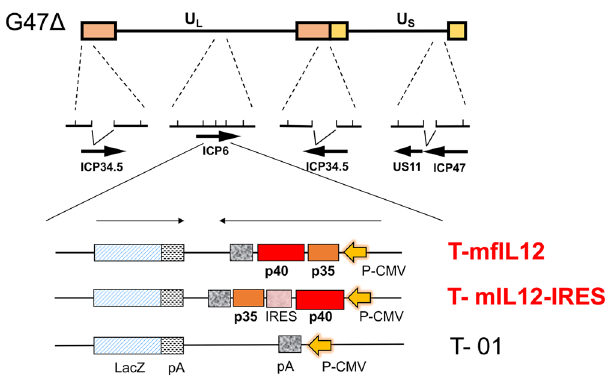
Fig. 1 The structures of T-mfIL12 and T-mIL12-IRES. The boxes (top line) represent inverted repeat sequences fl anking the long (U L ) and short (U S ) unique sequences of HSV-1 DNA. Oncolytic HSV-1 uses G47 Δ as the backbone and contains 1.0 kb deletions in both copies of the γ 34.5 gene, a